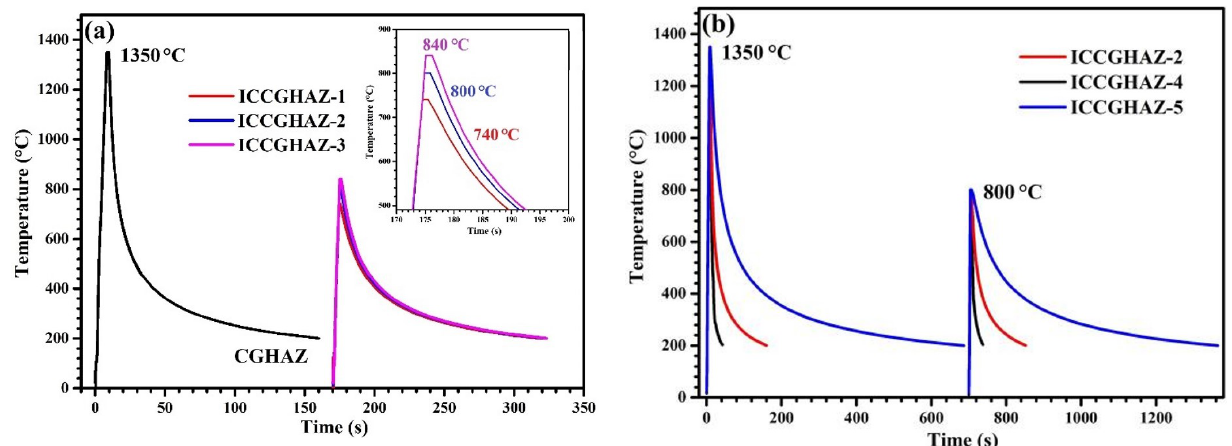
Figure 2. Schematic diagrams of the welding thermal cycles for different samples: ( a ) different secondary peak temperatures and ( b ) different cooling rates.